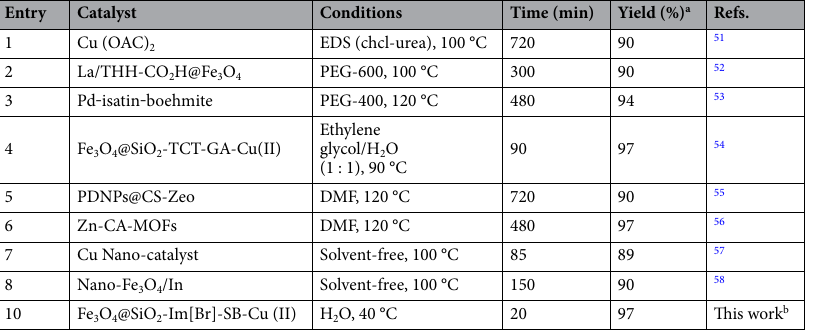
Table 5. Comparison of Fe 3 O 4 @SiO 2 -Im[Br]-SB-Cu (II) with other catalysts in synthesis of tetrazole derivatives. a Isolated Yield. b Aniline (1.0 mmol), Triethyl orthoformate (1.2 mmol), Sodium azide (1.0 mmol) and Fe 3 O 4 @SiO 2 -Im[Br]-SB-Cu (II) (0.6 mol %, 0.008 g). Benzaldehyde (1.0 mmol), hydroxy amine hydrochloride (1.0 mmol), Sodium azide (1.2 mmol) and Fe 3 O 4 @SiO 2 -Im[Br]-SB-Cu (II) (0.9 mol %, 0.012